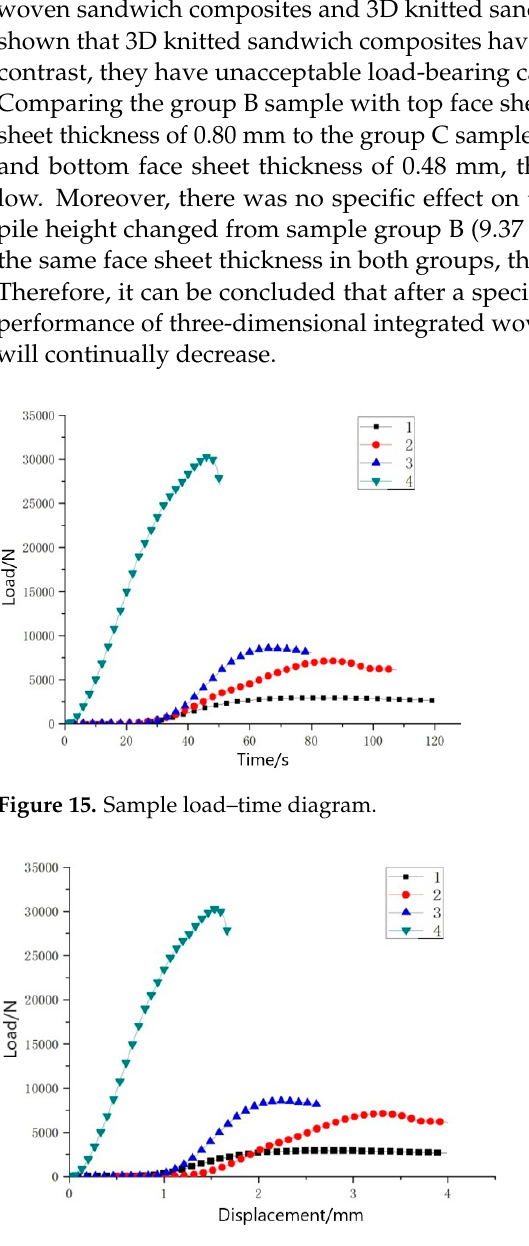
Figure 16. Sample load–displacement diagram.